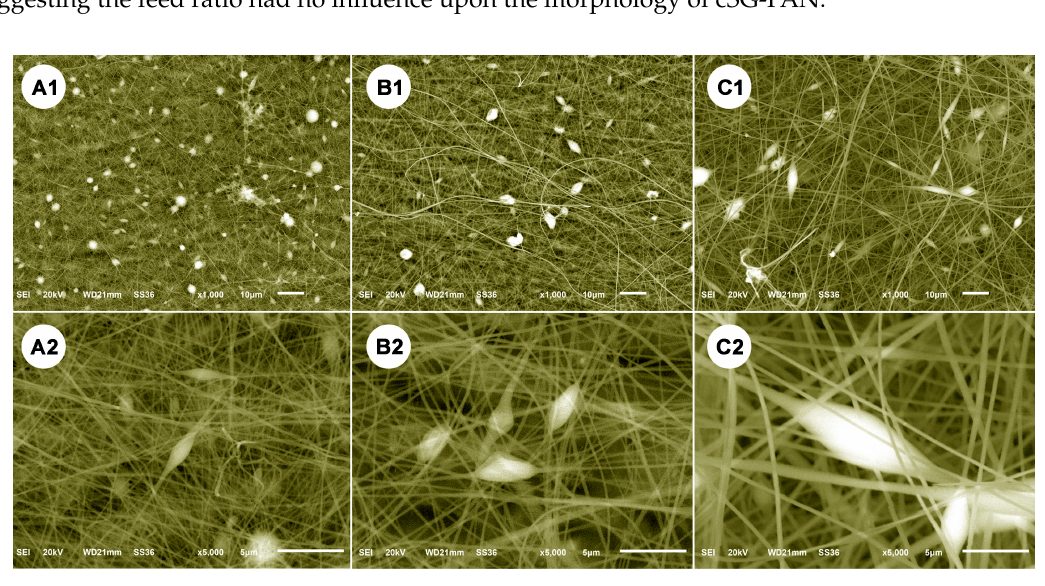
Figure 5. SEM images of cSG-PAN prepared with different feed ratios of cSG to PAN: ( A1 , A2 ) 1:5, ( B1 , B2 ) 1:10, and ( C1 , C2 ) 1:20.